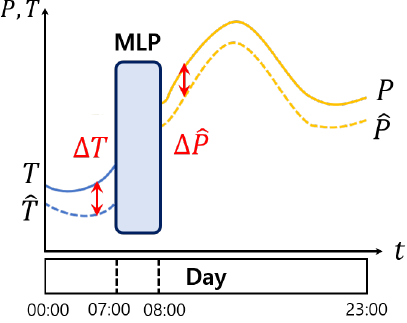
Figure 4. Relation between temperature deviation and load